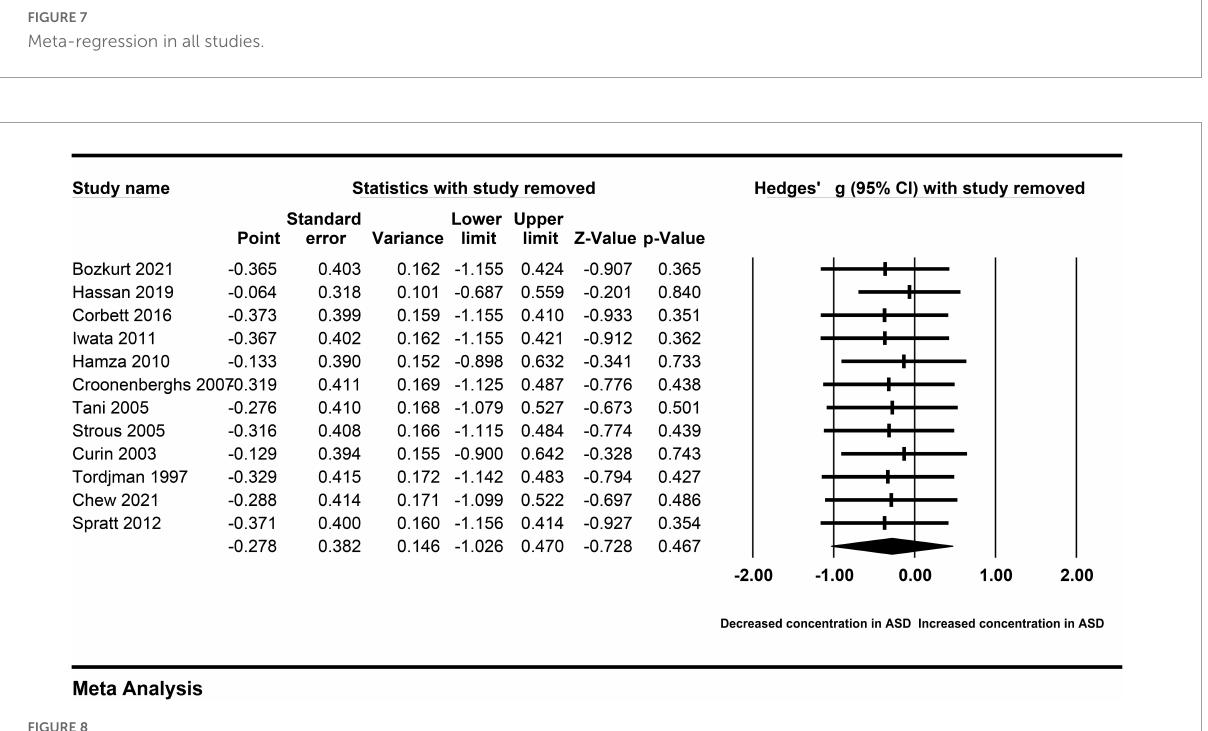
FIGURE8 Sensitivity